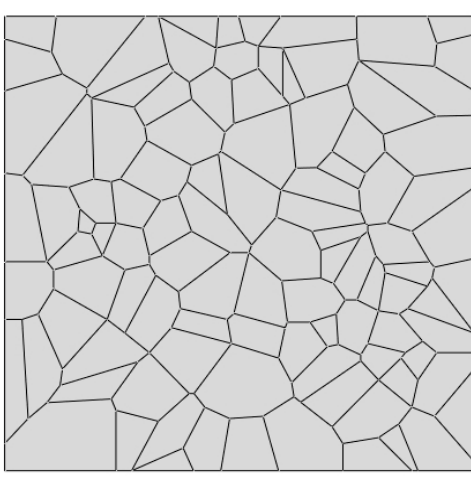
Figure 5. Two-dimensional polycrystalline model in ABAQUS.